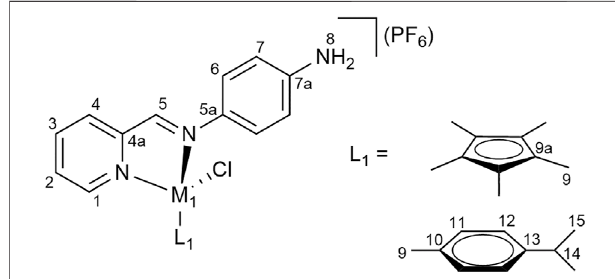
FIGURE 7 | NMR numbering scheme for complexes 1a – 1c